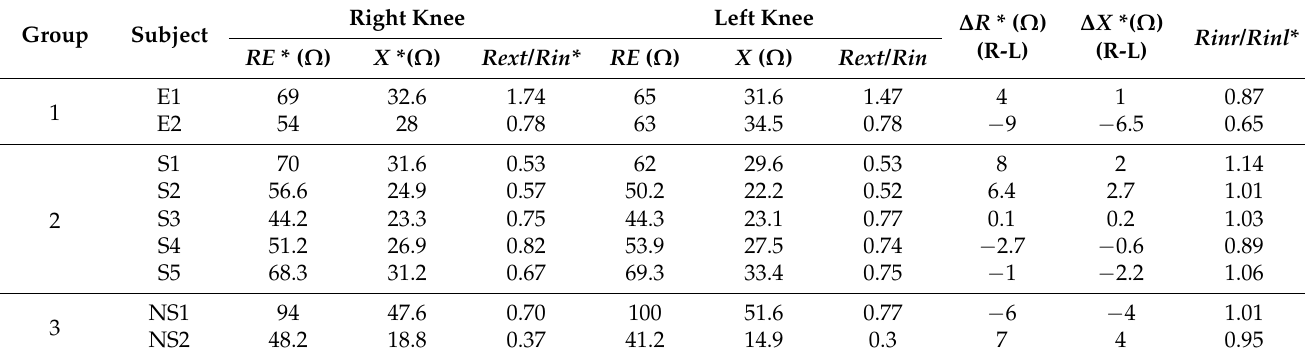
Table 2. Bioimpedance parameter values for all the examined